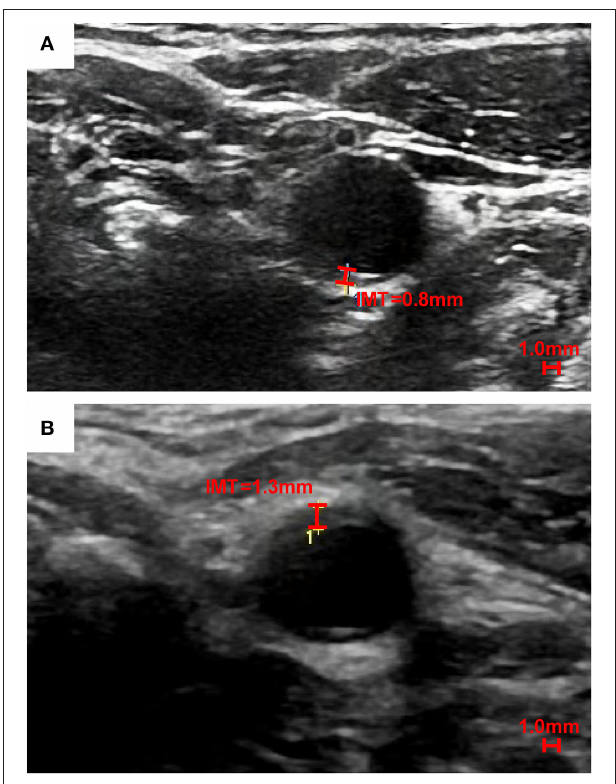
FIGURE 1 | A single-angle cross-sectional scan of the near wall and far wall CIMT of the left CCA. To better show the distinction between the near wall and far wall of common carotid artery, we choose the cross section. The far wall CIMT of a 50-year-old Chinese man is 0.8mm in (A) , while the near wall CIMT of a 41-year-old Chinese man is thicker (1.3mm) than the far wall CIMT in (B) .